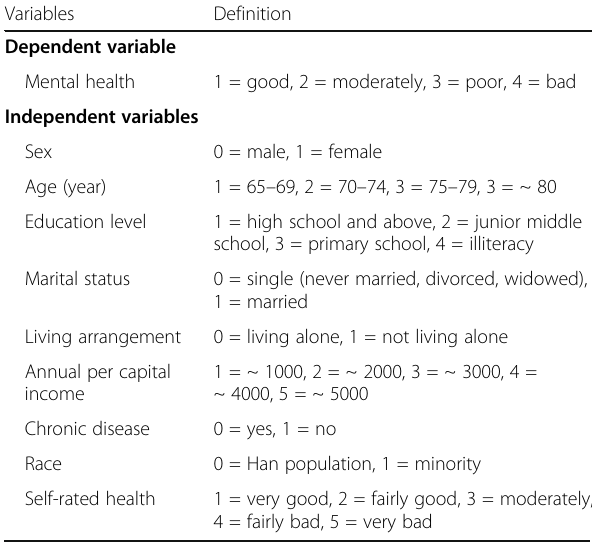
Table 4 Assignment of logistic regression analysis